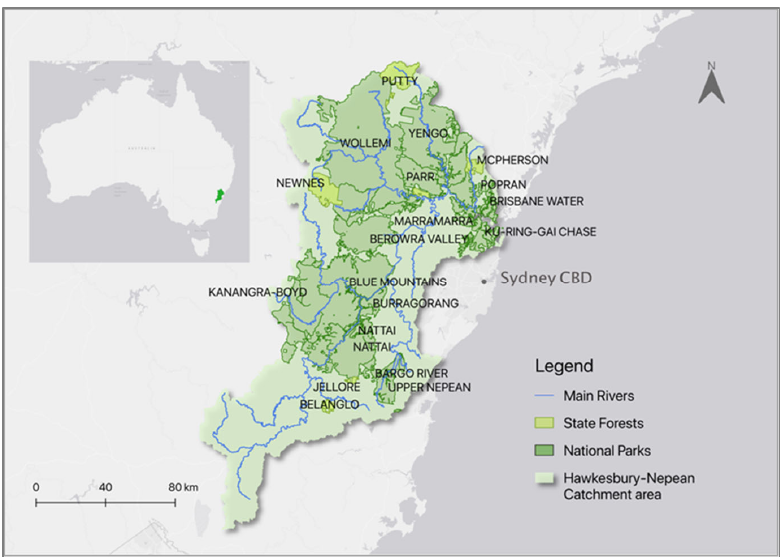
Figure 2. Map of the Hawkesbury ‐ Nepean catchment area including both national and state parks as well as the main rivers located throughout the catchment as of 2022.